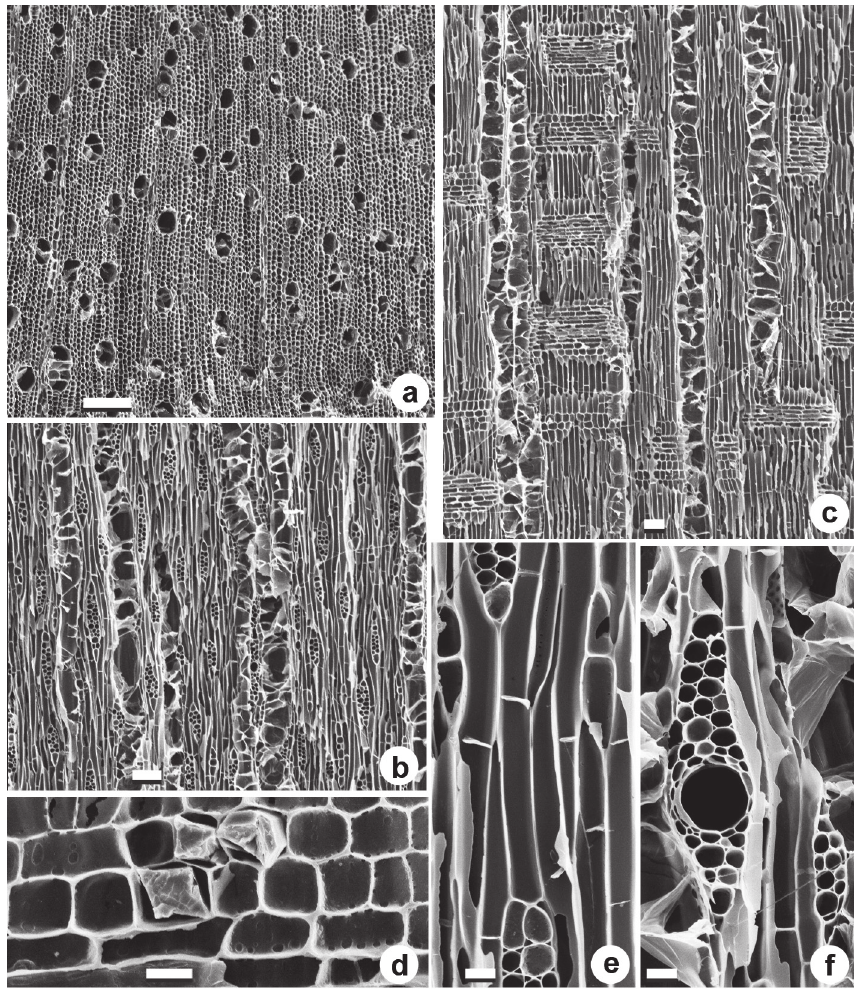
Figure 5. Spondias mombin (ME 201). Gold-coated, CETEM. - a : Transverse section. - b : Tangential section. - c : Radial section. - d : Prismatic crystals in ray cells. - e : Septate fibres. - f : Radial canal. Bars = 100 µm ( a-c ) and 20 µm ( d-f ).